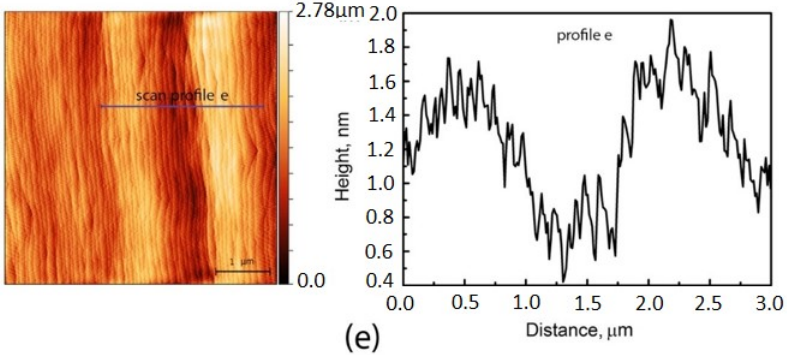
Figure 4. AFM images of GaAs layer surface (left) and scan profiles (right) for St-L-L ( a ), St-L-H ( b ) samples, and the SAE-L-W sample ( c – e ). The latter images ( c – e ) were obtained for A, B, and C points inside the window, as shown in Figure 1b.